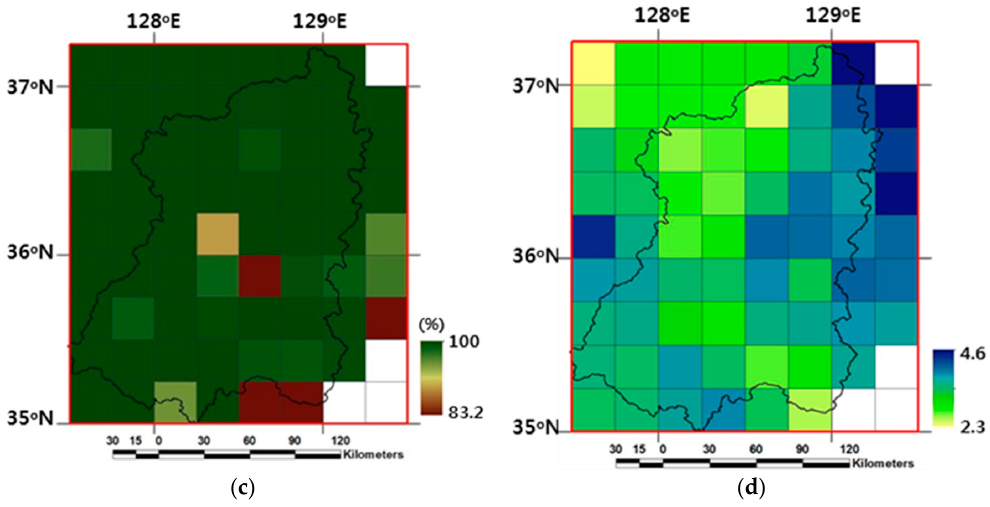
Figure 2. Spatial distributions of vegetative surface boundary conditions for ( a ) land cover category (3: irrigated cropland and pasture, 6: cropland/woodland mosaic, 10: savanna, 15: mixed forest, and 16: water bodies); ( b ) albedo; ( c ) fractional vegetation cover; and ( d ) July’s leaf area index on 30-km computational grids over the study domain.